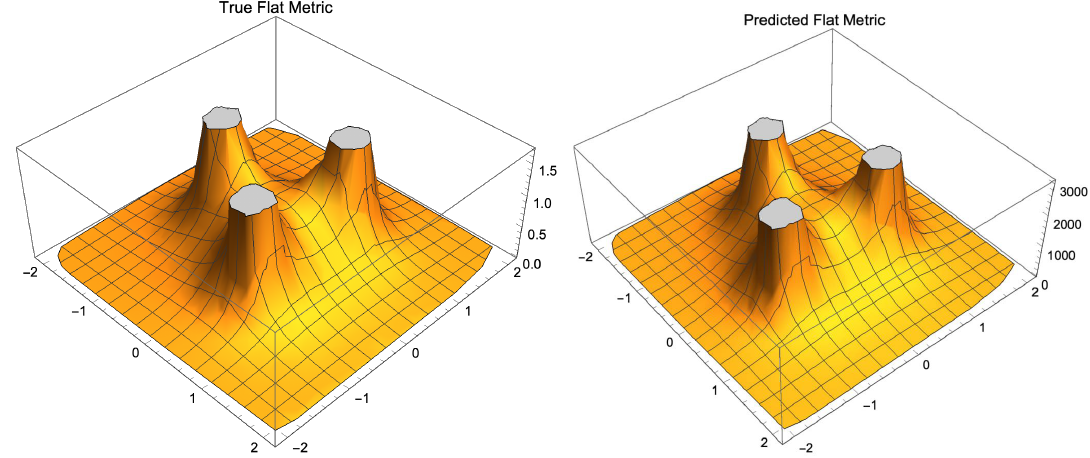
Figure 5 . True and predicted Ricci flat metrics on the complex torus (7.2). The axes are given by the real and imaginary parts of the independent coordinate z . The three peaks appear at points 1 = − 1 for which the coordinate z = 0 . Note that these apparent singularities for the metric are z 3 2 1 not there if one takes z as the dependent coordinate for those points. The predicted metric differs 2 from the true metric by an overall scaling thus yielding a vanishing Ricci curvature.